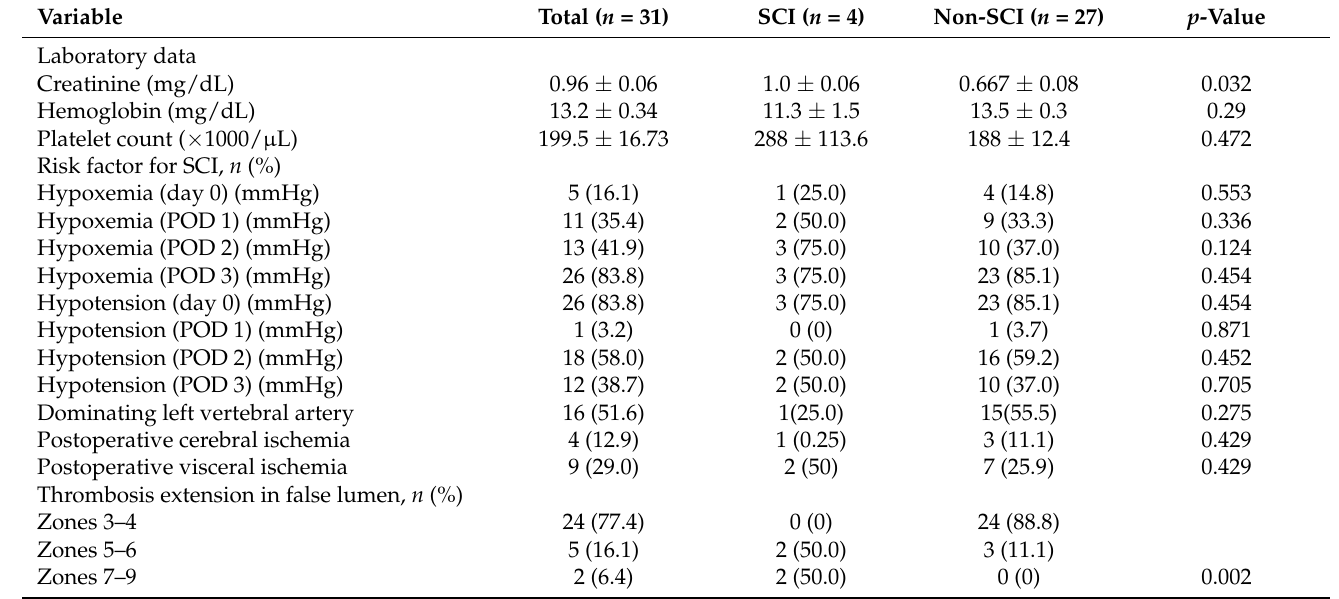
Figure 3. CT scans (sagittal view) of SCI patient. ( Left ): Proximal descending aorta after FET with two visible posterior intercostal arteries without contrast enhancement. ( Right ): Distal aorta of the same patient showing thrombosis of false lumen up to zone 9. Table 3. Postoperative